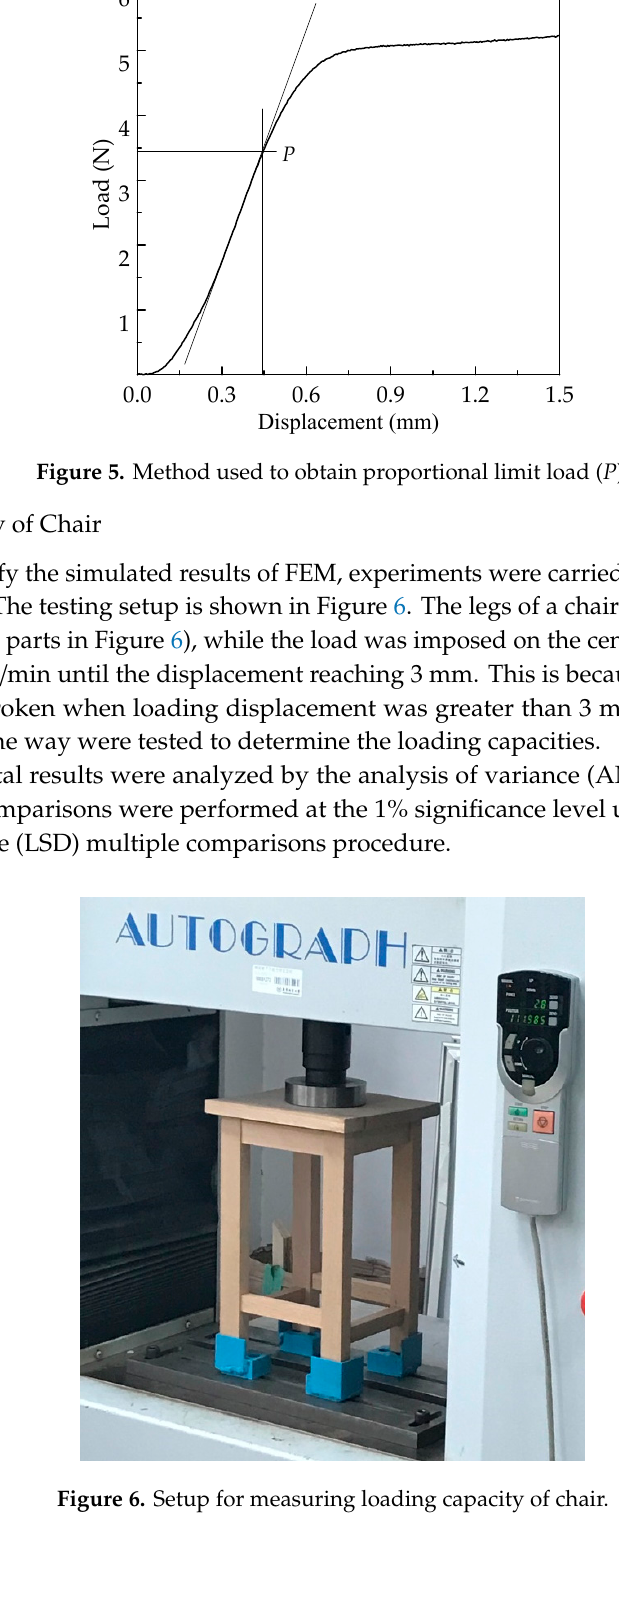
6 of 14 Figure 4. Setup for measuring elastic constants of beech. 𝜎 (cid:3017)(cid:3013)(cid:3020) = 𝑃 𝐴 (cid:2868) ⁄